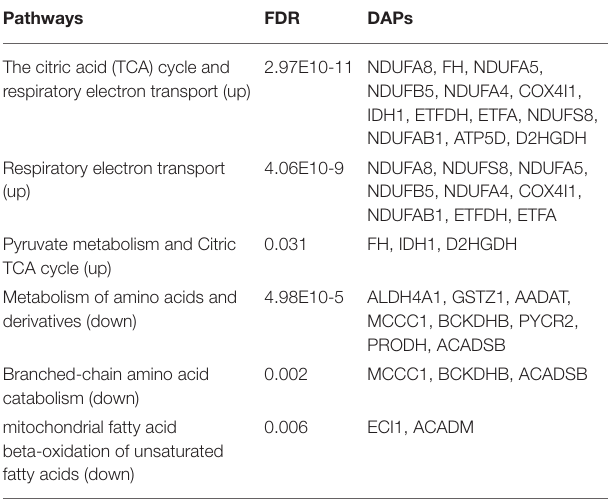
TABLE 1 | Key pathways related to brain mitochondrial